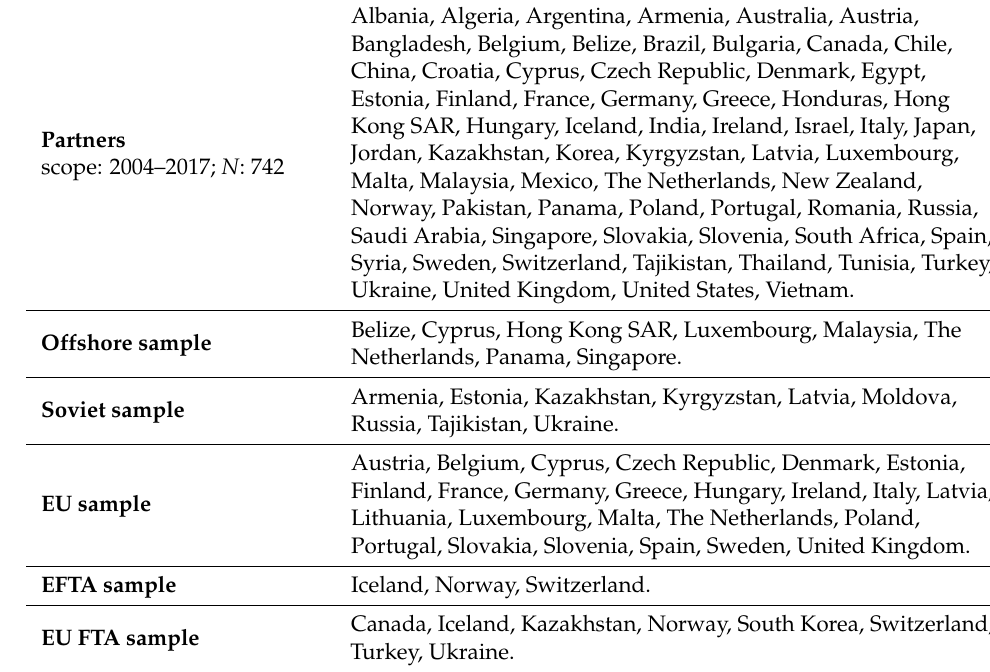
Table A3. List of inward FDI partners for Lithuania.